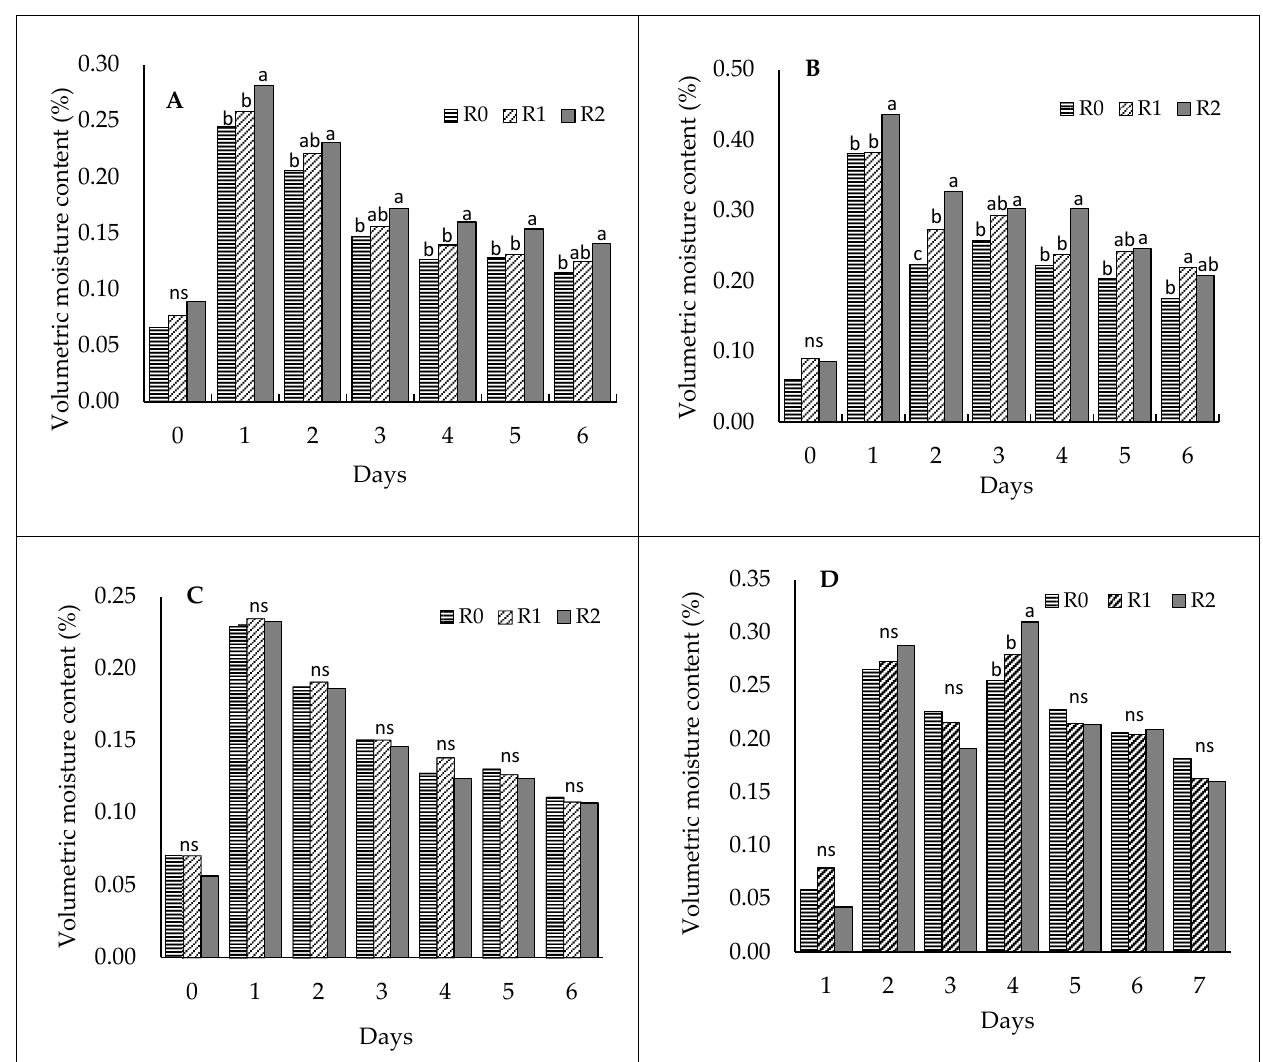
Figure 4. ( A – D ) Soil volumetric moisture content as a function of biochar rates before irrigation and for six successive days after irrigation in pinto bean 2017 ( A ), pinto bean 2018 ( B ), sorghum–Sudan 2017 ( C ), and sorghum–Sudan 2018 ( D ). Day = 0: the day before irrigation; Day = 1: irrigation took place; Day = 2, 3, 4, 5, 6: successive days after irrigation. Biochar rates for pinto bean: 0 Mg ha − 1 (R0), 2.2 Mg ha − 1 (R1), and 11.2 Mg ha − 1 (R2). Biochar rates for sorghum–Sudan: 0 Mg ha − 1 (R0), 3.4 Mg ha − 1 (R1), and 6.7 Mg ha − 1 (R2). a, b, c: bars with different letters indicate significant treatment difference within a given day at p ≤ 0.05, ns: no significant treatment